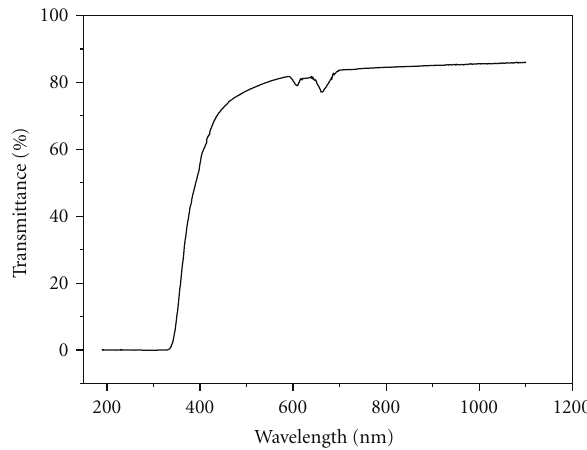
Figure 1: UV-visible spectrum of the ZnO-MB